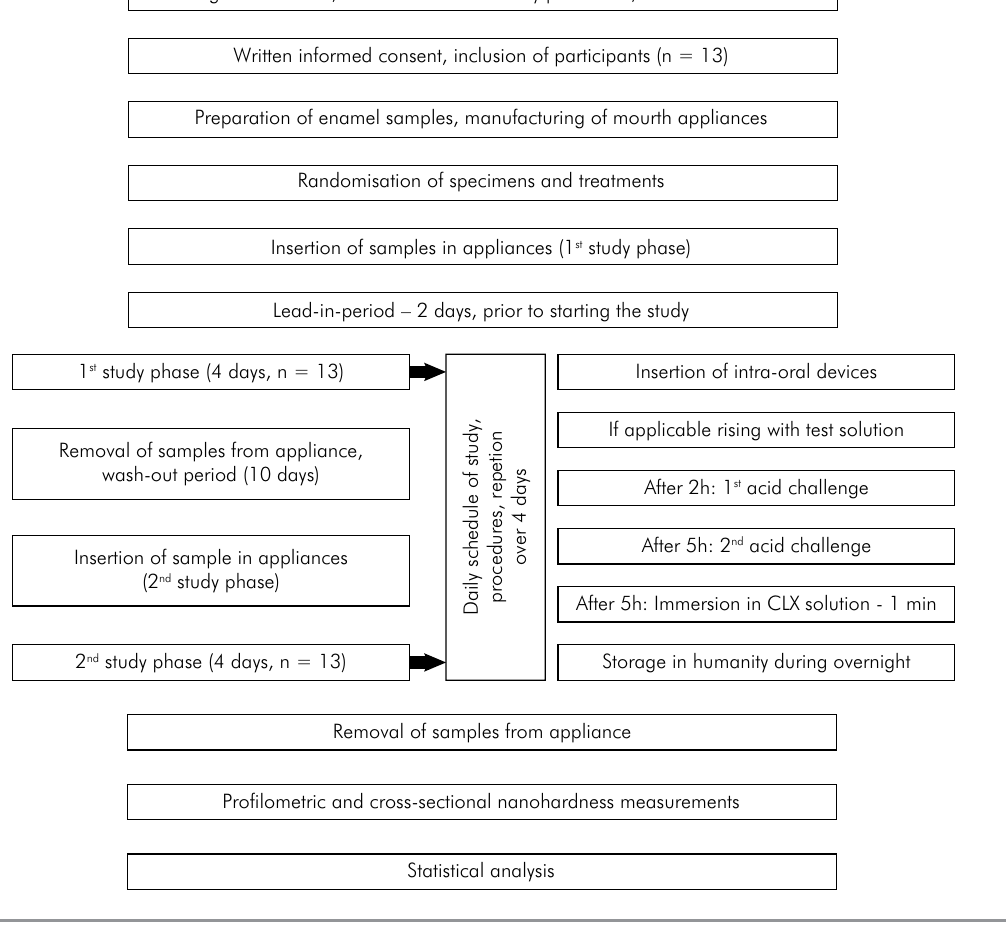
Figure. Flow chart of study